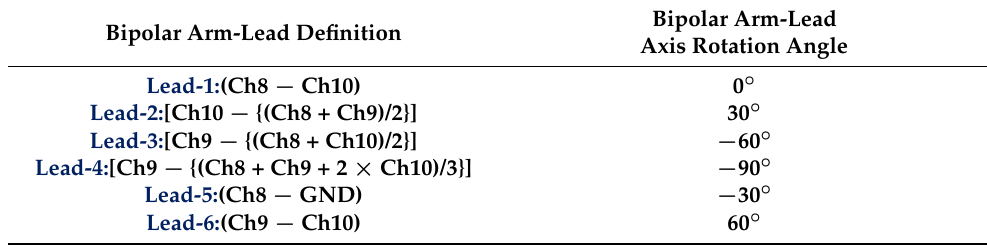
Bipolar Arm-Lead